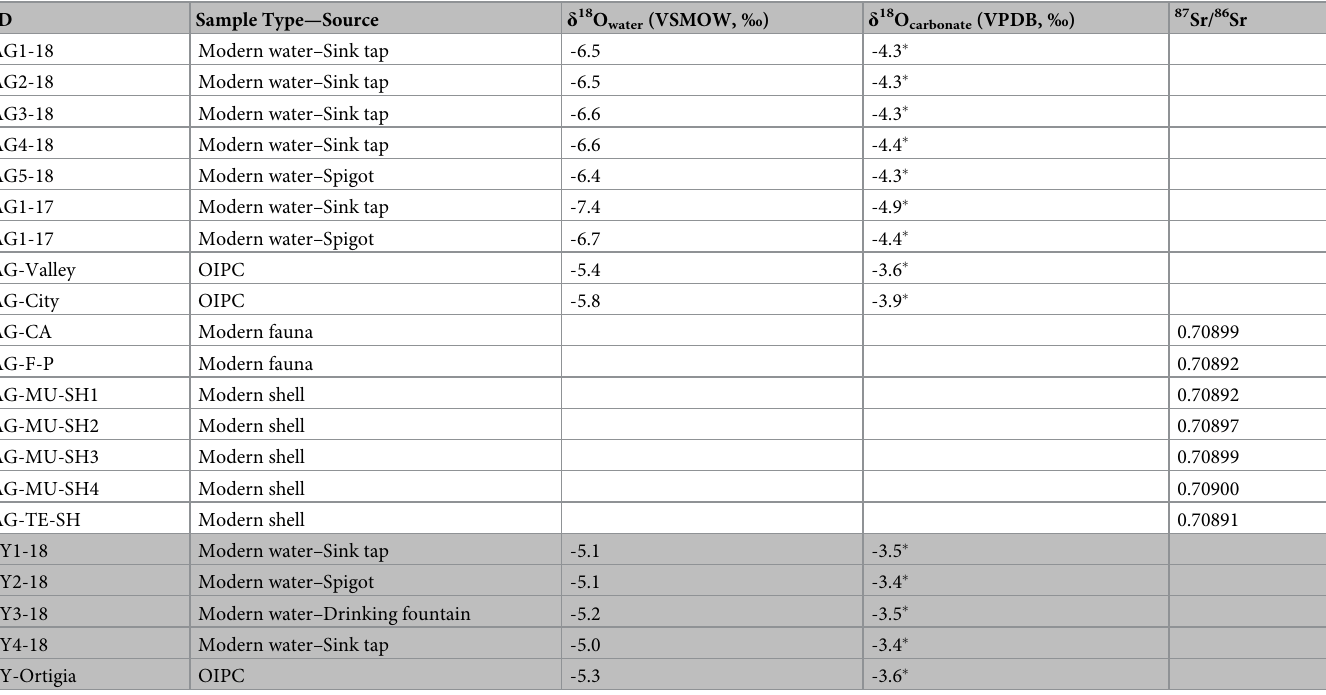
Table 2. Agrigento (AG) and Syracuse (SY) isotopic